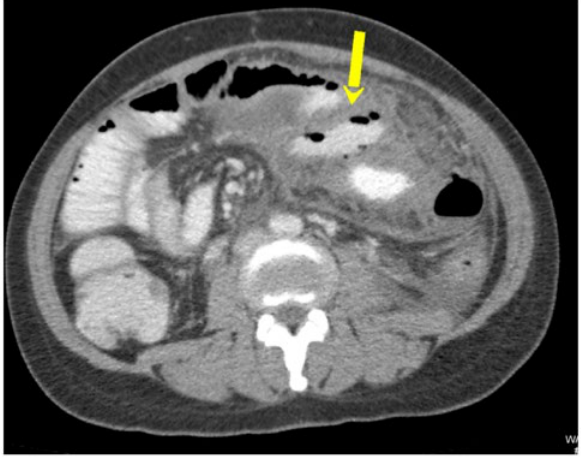
Figure 8b: SBO in a known patient with tuberculosis complicated by perforation. Extraluminal contrast filled collection (yellow